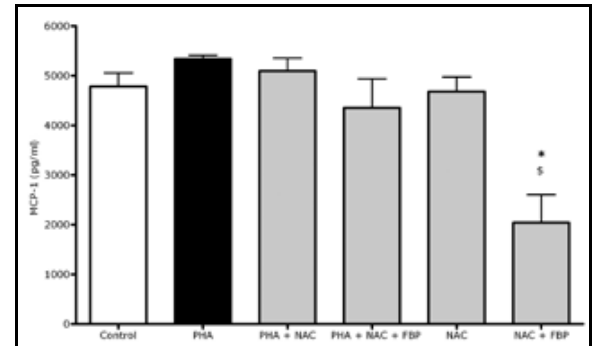
Figure 4 – Effects of NAC (15 mM) and FBP (1.25 mM) in MCP-1 levels. The results are presented in absolute values in triplicate cultures and expressed as mean ±